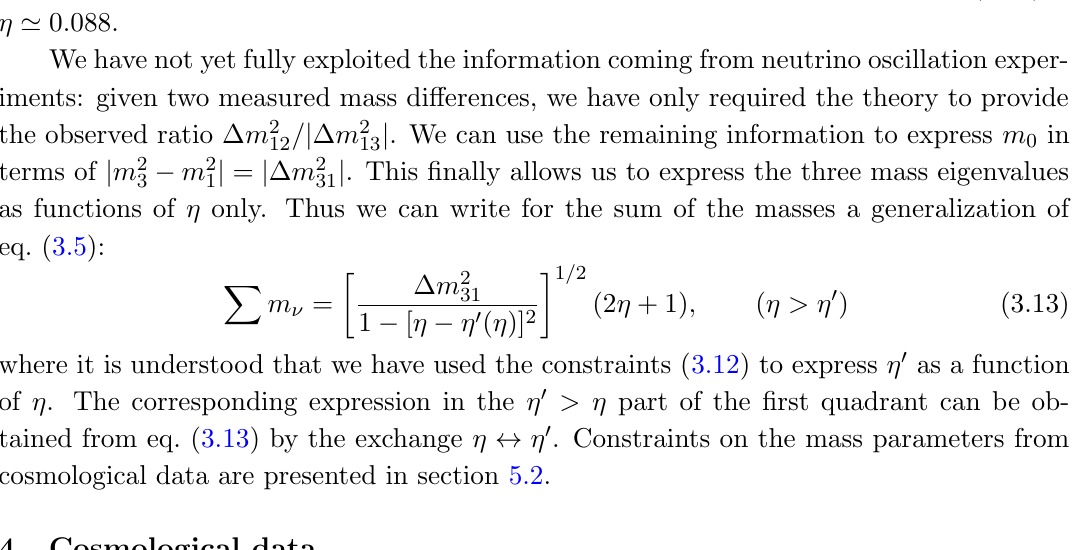
= j (cid:1) m 2 j . The whole ( (cid:17); (cid:17) 0 ) 12 13